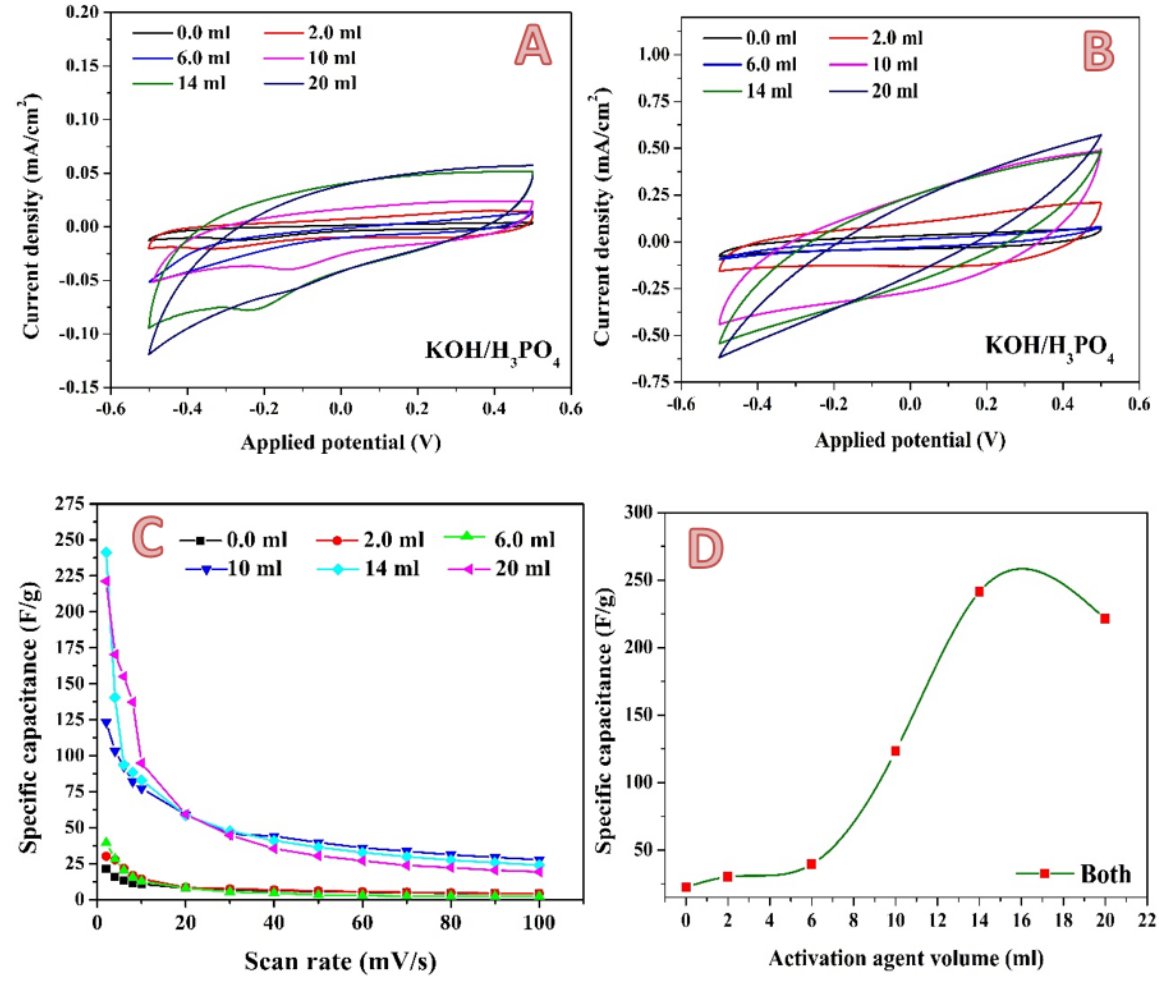
Figure 10. Cyclic voltammograms in the presence of 0.1 M H 2 SO 4 electrolyte at a scan rate of 2 mV; ( A ) and 100 mV/s; ( B ) for the 0.3 g activated carbon obtained from rice husk using different volumes of KOH/H 3 PO 4 mixed activation agent. Influence of the scan rate on the specific capacitance; ( C ) and effect of the alkaline solution volume on the specific capacitance (at 2 mV/s); ( D ).